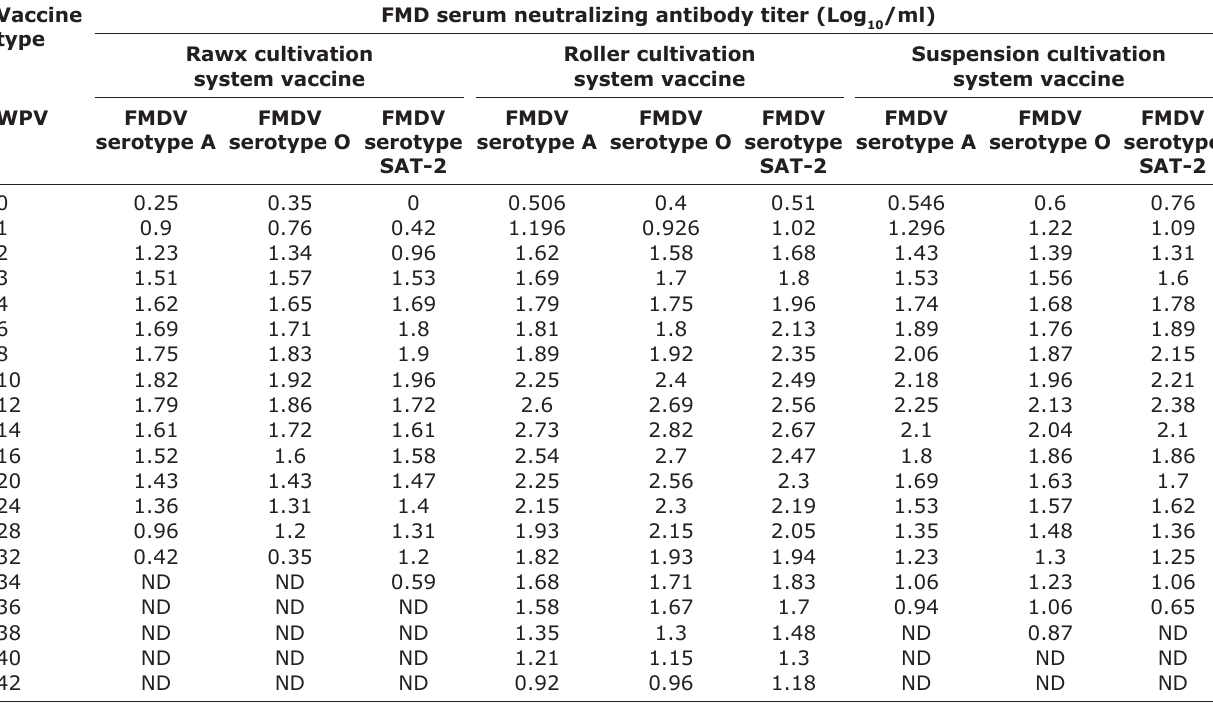
Table-2: Tracing of FMD serum neutralizing antibody titer induced by the vaccines prepared by different culture systems. Vaccine type Rawx cultivation system